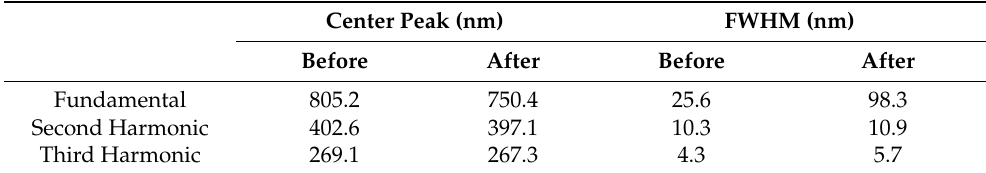
Table 1. The peak wavelengths and FWHMs of the fundamental, second-harmonic, and third-har- monic fields measured before and after they interact with filamentation-forming air plasma.